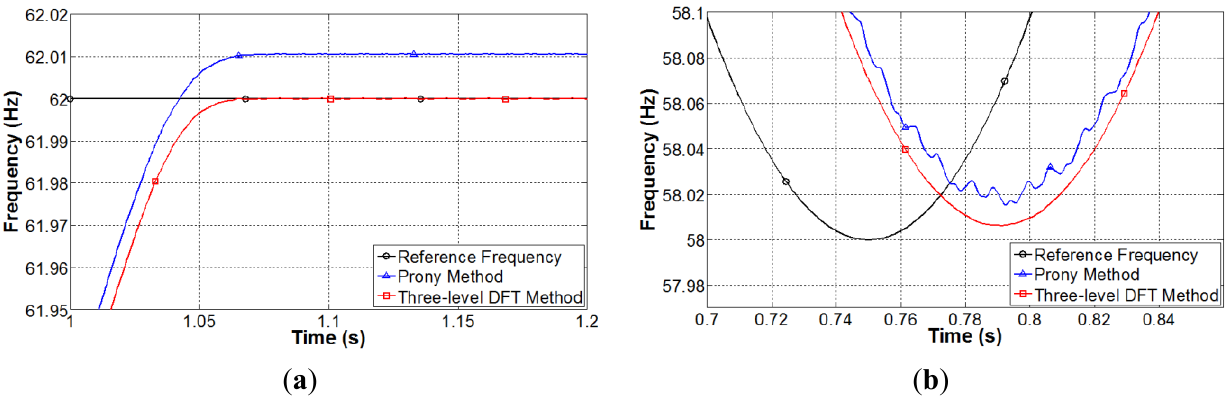
Figure 5. Estimation of ramp-up and sinusoidal frequency variations in the presence of harmonics. ( a ) Ramp-up frequency variation; ( b ) Sinusoidal frequency